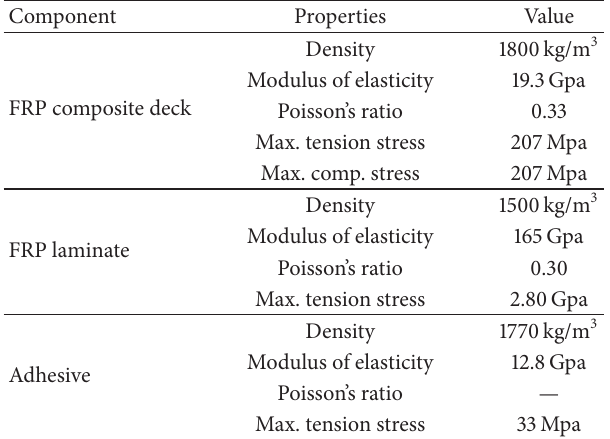
Table 2: Properties of special